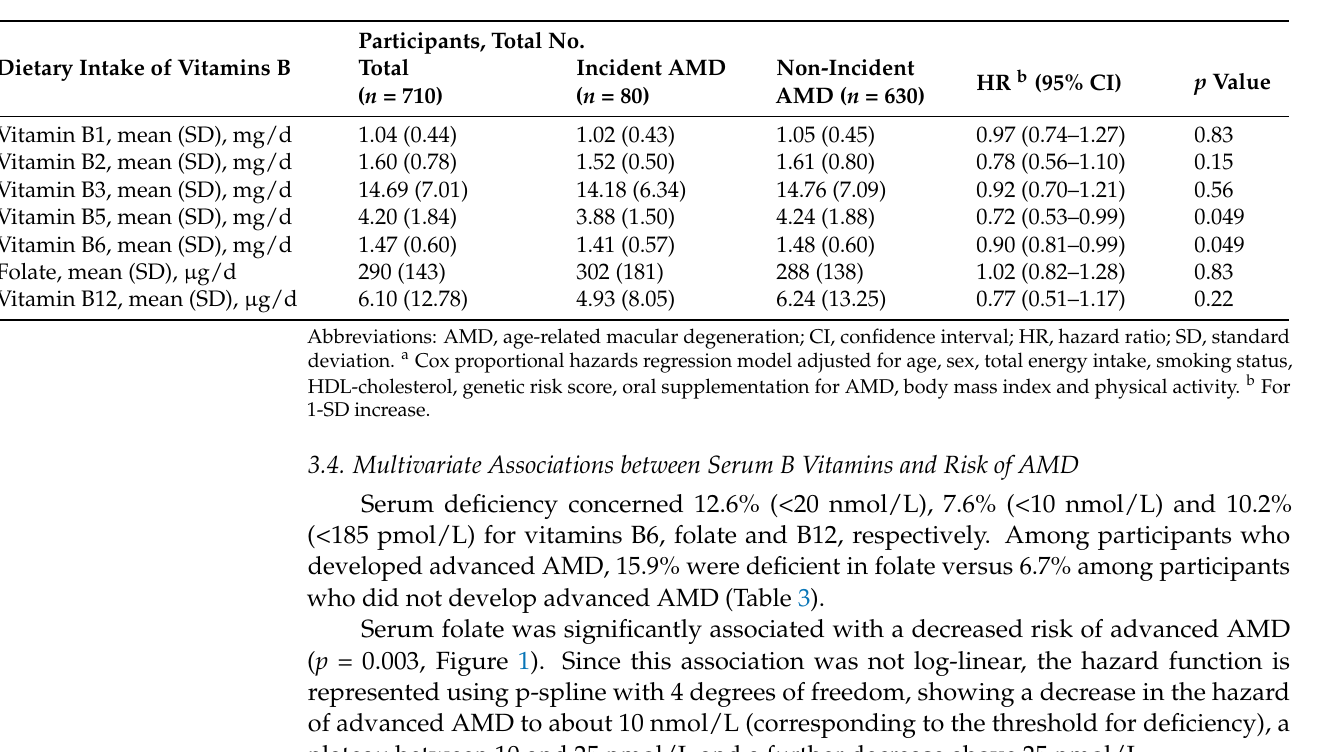
Table 2. Associations between dietary vitamins B and incidence of advanced AMD in the Alienor Study 2001–2017 a